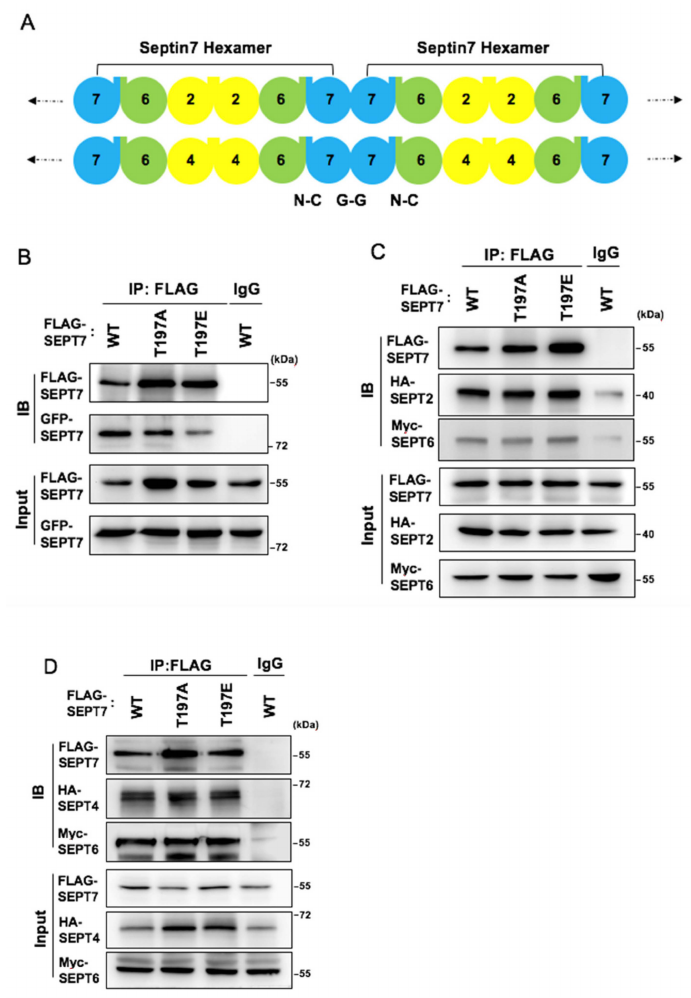
Figure 5. Mimetic phosphorylated Thr197 of SEPT7 disrupts SEPT 7-7 complex but does not affect SEPT 2, SEPT 4, and SEPT 6 interaction. ( A ) Schematic representation of a heteromeric SEPT7– SEPT6–SEPT2 or SEPT7–SEPT6–SEPT4 complex. SEPT7 has been included at the terminal positions (shown in blue). The SEPT 7-SEPT 7 pairwise interactions occur at the G-interface, whilst the SEPT 7-SEPT 6 dimer is stabilized by the NC interface. SEPT7 phosphorylation affected SEPT7- SEPT7 interaction ( B ) but not SEPT 2, SEPT 4, or SEPT 6 interaction ( C , D ). ( B ) FLAG-SEPT7 and GFP-SEPT7 were co-transfected into NT2/D1 cells. Lysates from transiently transfected cells were immunoprecipitated by FLAG or GFP with antibodies against GFP and FLAG. ( C , D ) Myc-SEPT6, HA-SEPT4, and HA-SEPT2 with various FLAG-SEPT7 plasmids were transfected into NT2/D1 cells, and lysates were immunoprecipitated with an anti-FLAG antibody. The expression of SEPT2, 4, 6, and SEPT7 were detected by anti-HA, anti-Myc, and anti-FLAG antibodies, respectively. IgG served as the negative